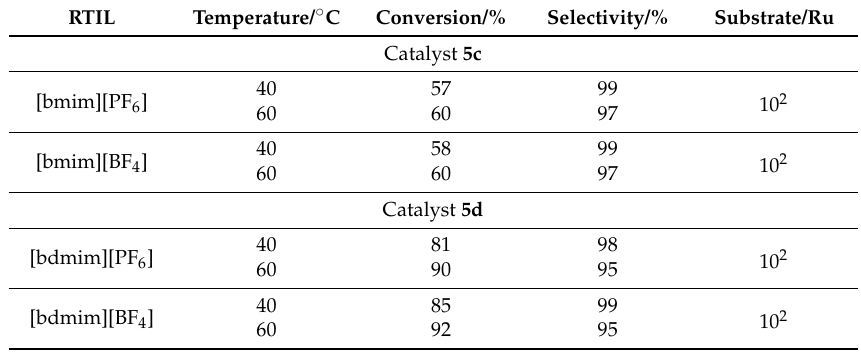
Table 2. Activity and selectivity of Hoveyda-Grubbs catalysts 5c and 5d on methyl oleate in ILs. RTIL Temperature/ ˝